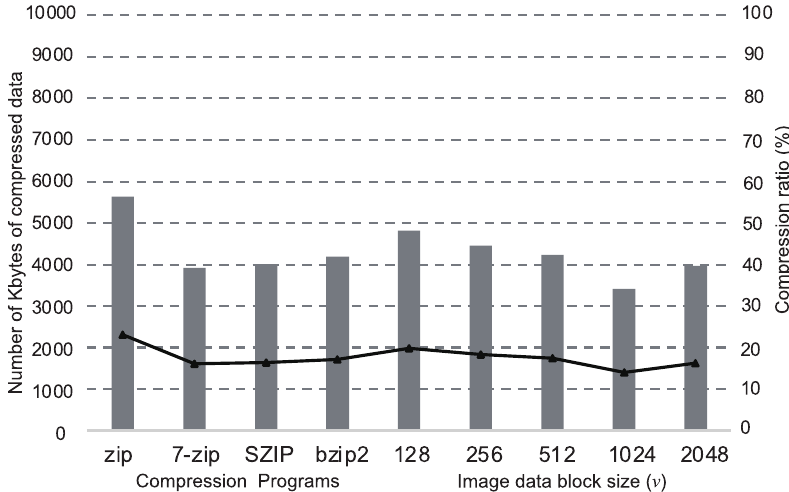
Figure 6. Comparisons of compression ratios with/without the DNN inference in the case of Bosphorus.